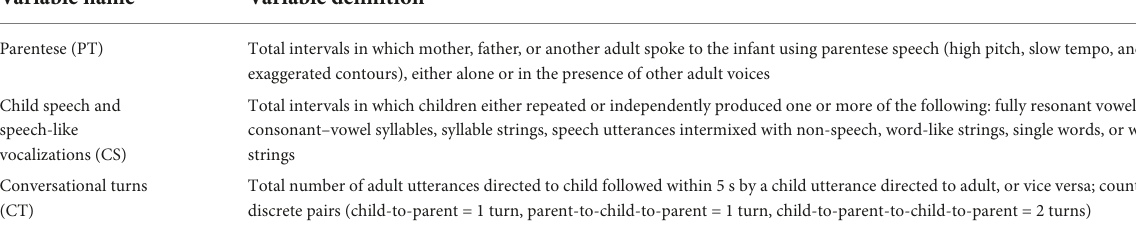
TABLE 1 Parent and child language variables measured from 6 to 24